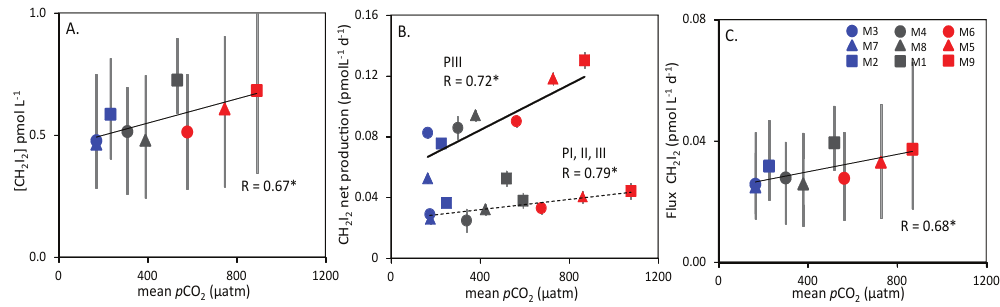
Fig. 4. Relationships in PIII between (A) mean CH 2 I 2 concentration (pmold − 1 ) and mean p CO 2 (µatm), (B) the mean net production rate of CH 2 I 2 (pmolL − 1 d − 1 ) and mean p CO 2 (µatm) for PI–PIII (dashed line) and PIII only (solid line), and (C) the mean sea-to-air flux of CH 2 I 2 (pmolm − 2 d − 1 ) , all for Phase III ( t 22 – t 27 ) . Asterisks denote significance level of correlation ( R ): ∗ = p < 0.05, ∗∗ = p < 0.01. Error bars show range of data.